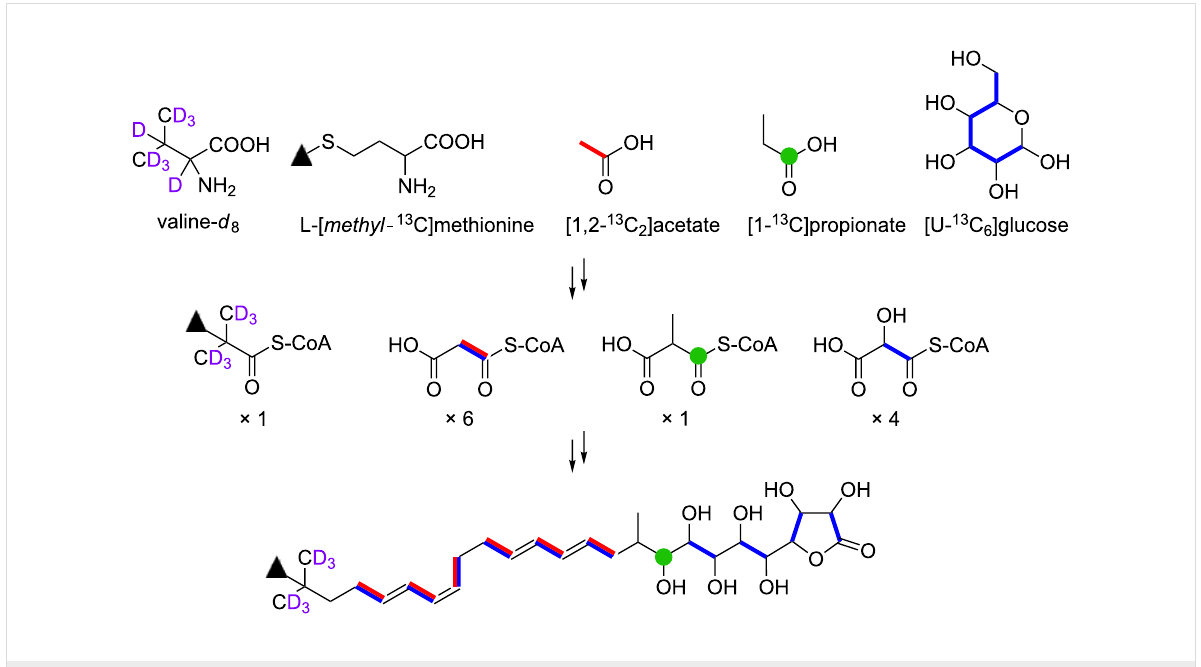
Figure 8: Incorporation of 13 C- and 2 H-labeled precursors into 1